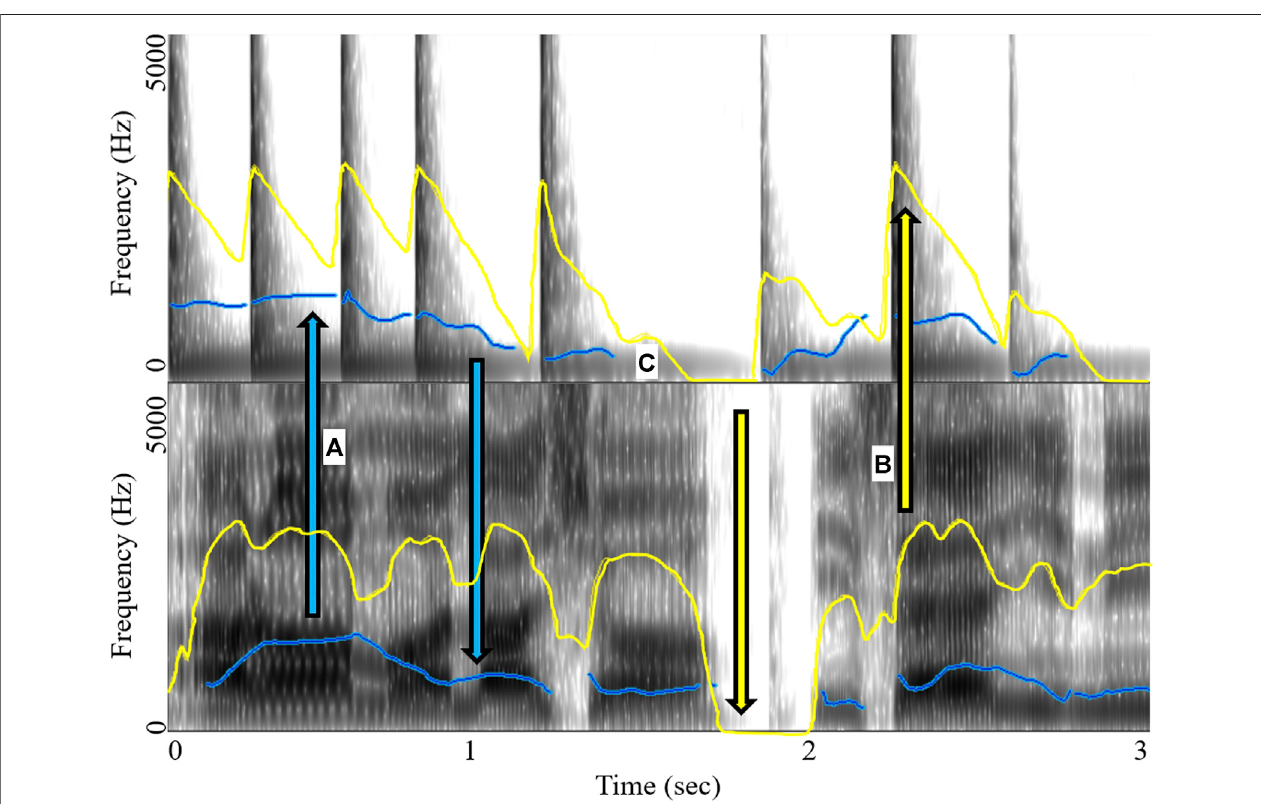
FIGURE 9 | Fundamental frequency ( f 0 ) and intensity contours for drum and speech. This exemplar of the f 0 and intensity data (pulled from Praat for Drummer B ’ s Song5,whichexhibitedan f 0 correlationof r (429) (cid:1) 0.80andintensity r (664) (cid:1) 0.50)showsthecorrelatedmovementsbetween (A) drumandspeech f 0 and (B) drumand speechintensity.Thisgraphicalsoshows (C) gapsthatappearinthedata(mostoftenin f 0 ),whichareoftencausedbyanactuallackofdataatthemomentoradearthof data points that does not allow for an accurate estimate of the acoustic feature. Finally, the temporal asymmetry between samples is also evident. This is what necessitates the downsampling procedure to equalize the length of each sample phrase.